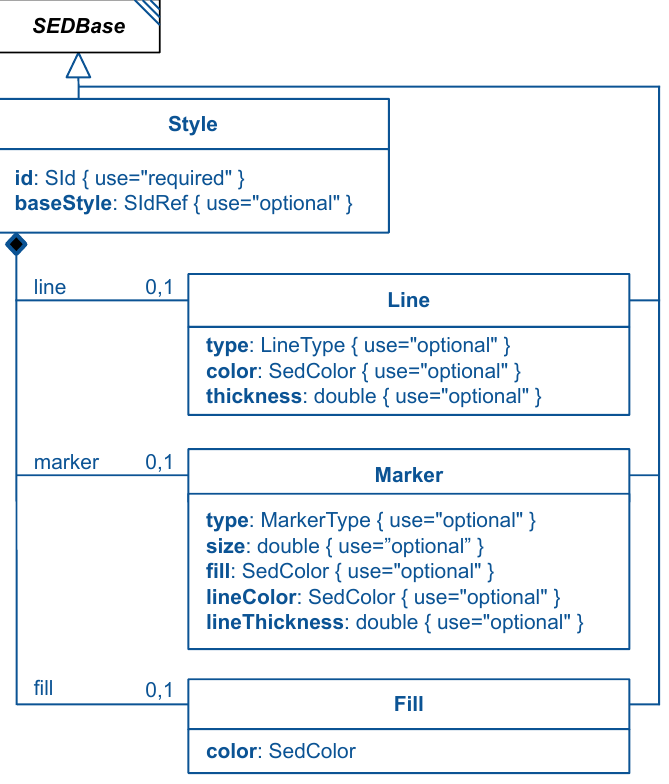
Figure 2.29: The SED-ML Style